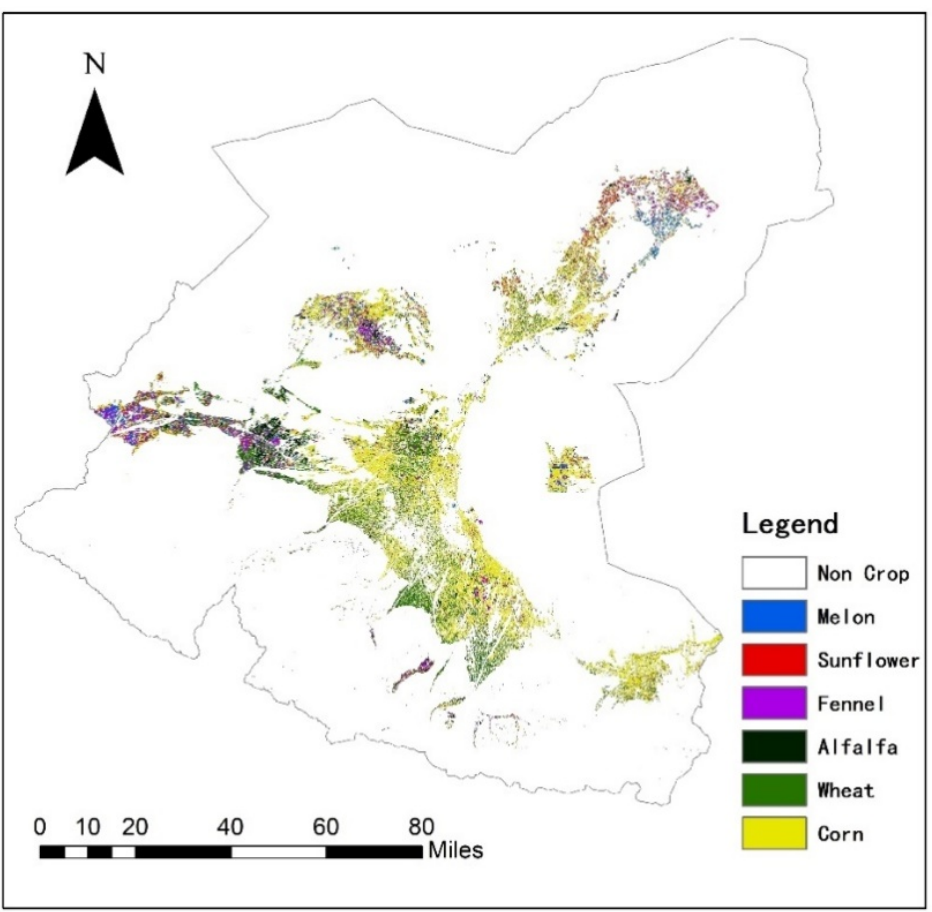
Figure 10. Early-season crop map for 2020 in the Shiyang River Basin obtained using the Conv1D network and the images acquired before DOY198 in 2020. The Conv1D network was trained using the images acquired before DOY198 in 2019 and the samples from 2019.